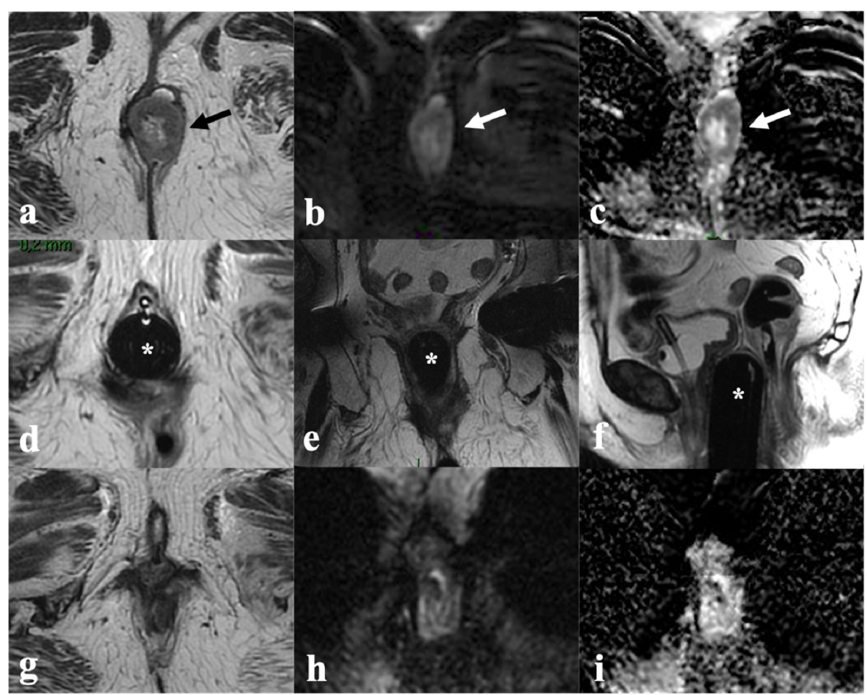
Figure 6. Locally advanced recurrence with satellite nodules. A 66-year-old patient previously treated with excisional biopsy and RT for squamous cell carcinoma of the right labium minus, presenting 3 years later with multiple solid pelvic nodules of intermediate T2 signal intensity, the largest in the lower III of vagina (( a , d )—black arrow), attached to the right lateral uterine wall (( b , c )—black arrow), in pelvic peritoneum (( c )—white arrowhead) and in the ischio-anal fossa (( c , d )—black arrowhead). Satellite nodules also show diffusion restriction (( e )—black star key) and peripheral enhancement (( f )—white star key).